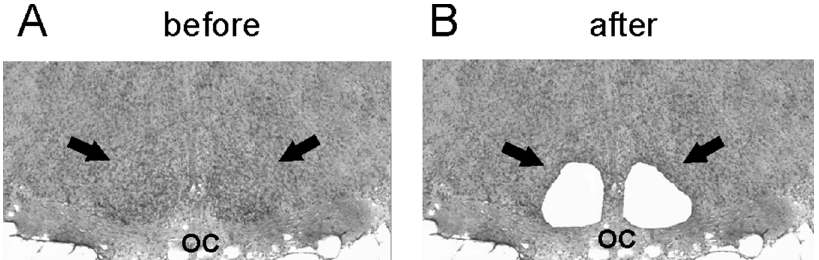
Figure 1. Representative coronal sections of the fetal rat brain at embryonic day 21 containing the hypothalamus. The sections were stained with cresyl violet and the position of the suprachiasmatic nuclei (SCN) is denoted (arrows). A . The intact section before the SCN dissection; B . The same section after the SCN dissection. For more details, see Materials and Methods. OC, optic chiasma. mented by the Prism 5 software (GraphPad, La Jolla, USA) was applied.